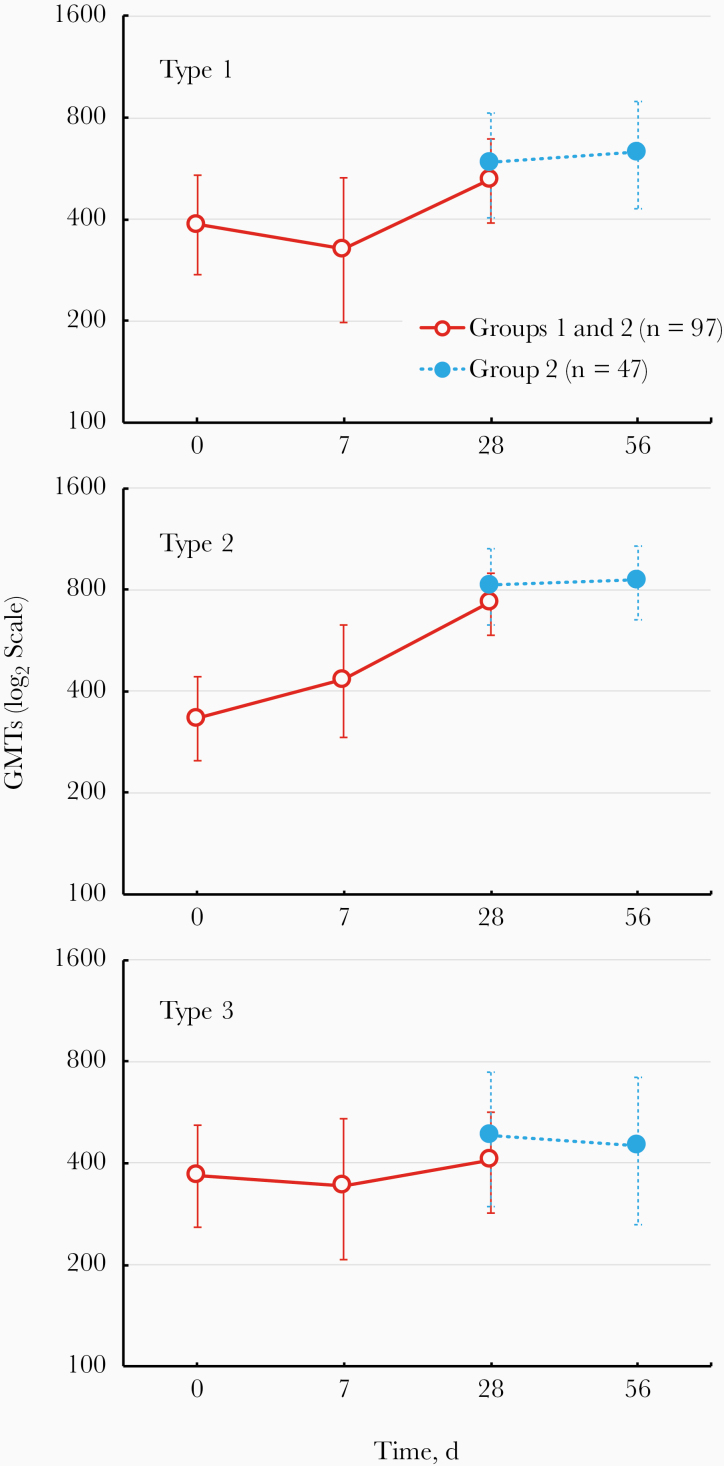
Geometric mean titers (GMTs) (with 95% confidence intervals) of neutralizing antibodies against the 3 poliovirus serotypes in the 2 study groups after 1 (red symbols) or 2 (blue symbols) challenge doses of and safety of monovalent type 2 oral poliovirus vaccine (mOPV2).